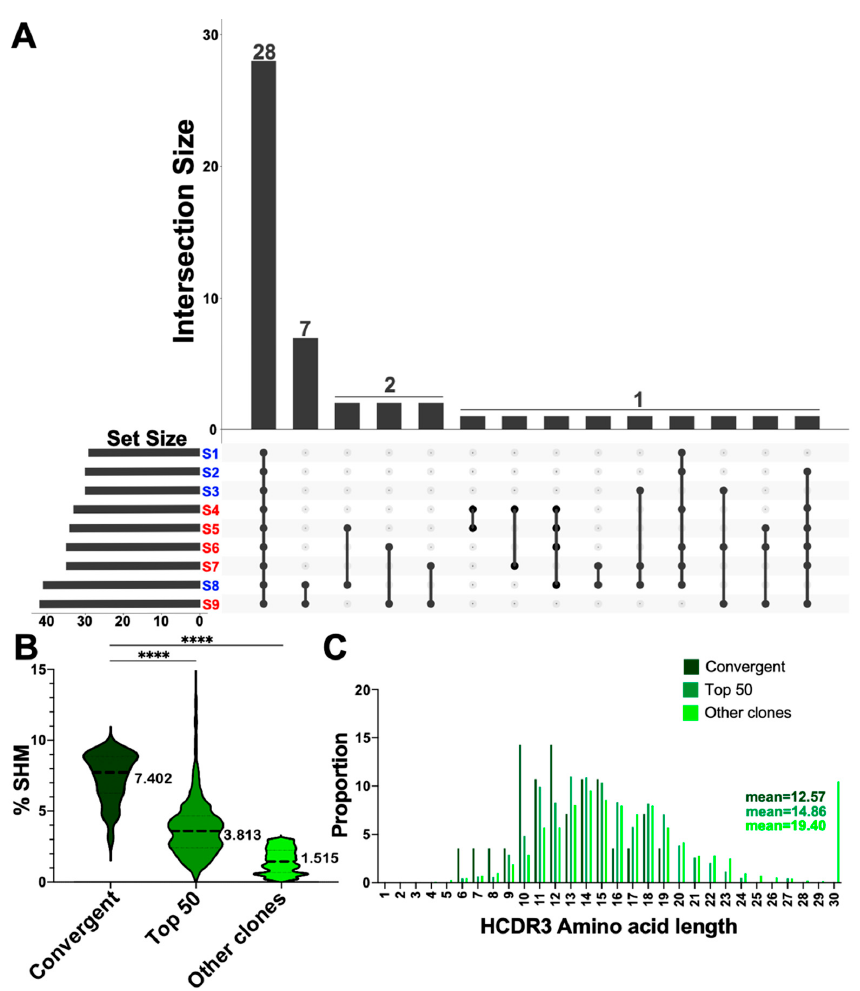
Figure 5. Convergent clones present at week 3. ( A ) Upset plot depicting convergent clones. In- tersection size (y axis) indicates number of clones, each bar is demarcated with number of unique clones. Connected dots below each bar indicate the number of individuals in which those clone(s) are present. Set size includes the total convergent clones for each sample. S1 – 9 indicate samples 1 – 9 red (seropositive) and blue (seronegative) ( B ) SHM percent comparison between the 28 convergent clones seen in ( A ), top 50 expanded clones and all other clones. Welch’s t- test, **** p < 0.0001. ( C ) HCDR3 length distribution of the 28 convergent clones (dark green), top 50 collapsed by serotype (jungle green), and other clones (lime green), means are indicated on the plot by color. Kolmogorov– Smirnov test, convergent vs. other, p = 0.0004. We then characterized the properties of the 28 convergent clones that were shared across all 9 individuals: HCDR3 length, V gene usage, and SHM. No difference was ob- served between the 28 convergent seropositive (mean = 7.617) and seronegative groups (mean = 7.500) ( t -test with Welch’s correction p = 0.8975). SHM was higher in the 28 con- vergent clone groups when compared to the top 50 expanded clone group ( t -test with Welch’s correction; p < 0.0001) and the remaining other clones in the repertoire ( t -test with Welch’s correction; p < 0.0001) (Figure 5B). The 28 convergent clone group had the highest SHM of any clone group observed in this study (convergent 28: 7.4027%; top 50: 3.813%; other clones:1.515%). HCDR3 length distribution was different from the remaining other clones in the repertoire, overall convergent clones had shorter HCDR3 lengths